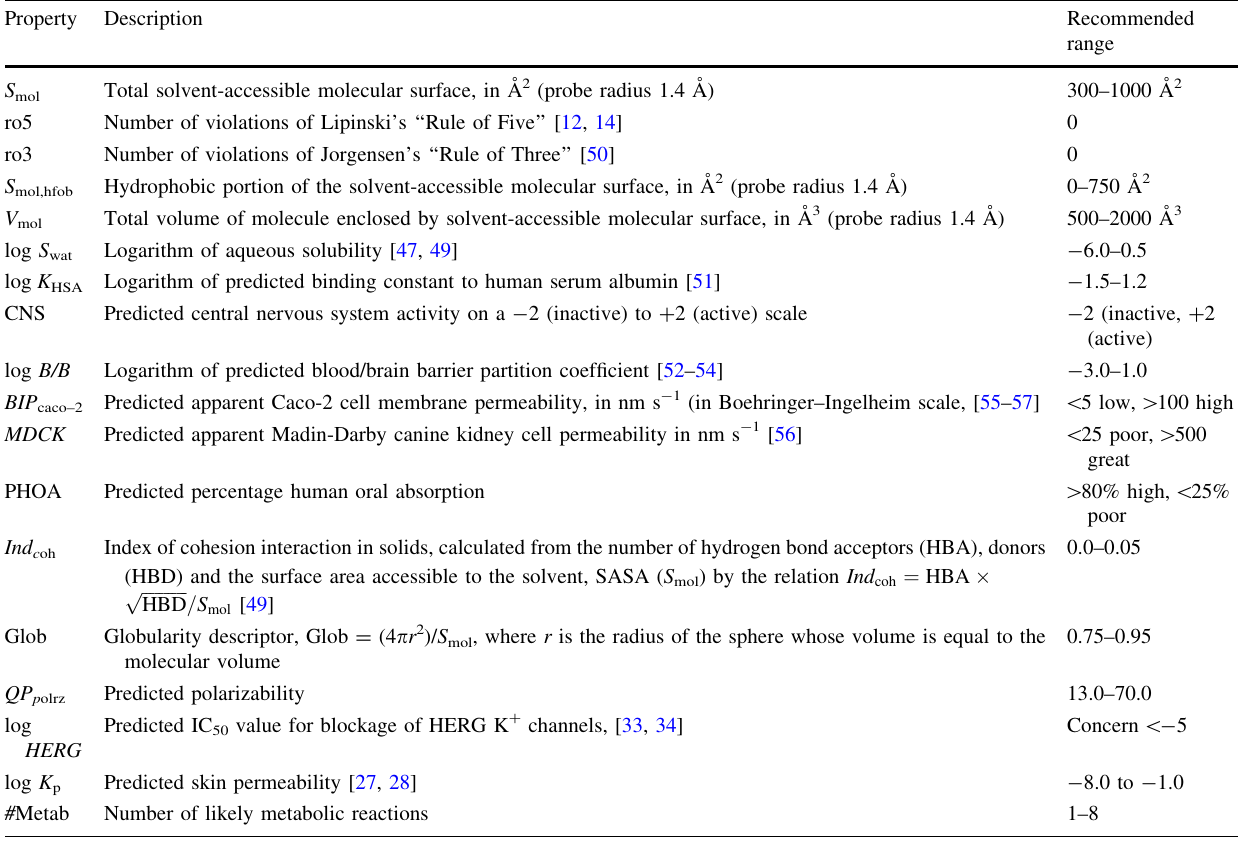
Table 1 Selected computed ADMET-related descriptors and their recommended ranges for 95% of known drugs